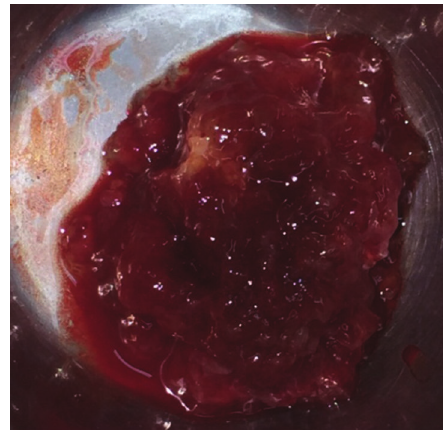
Figure 3: Macroscopic view of the surgically excised atrial mass.